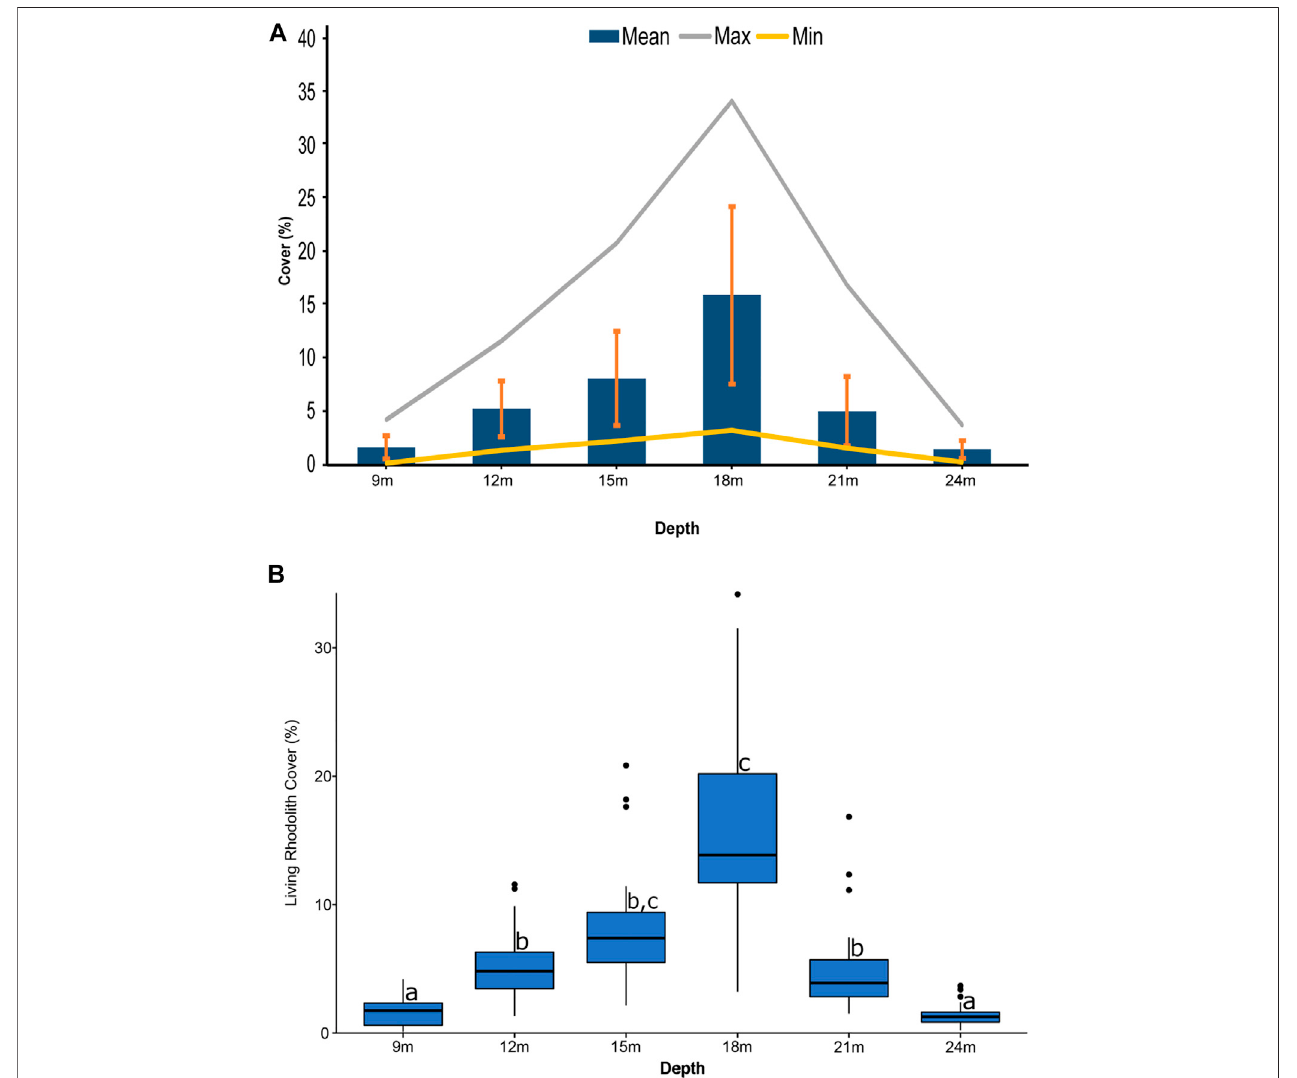
FIGURE 6 | (A) Rhodolith cover (mean and SD) and (B) boxplots of rhodolith cover illustrating signi fi cant differences detected across depths.